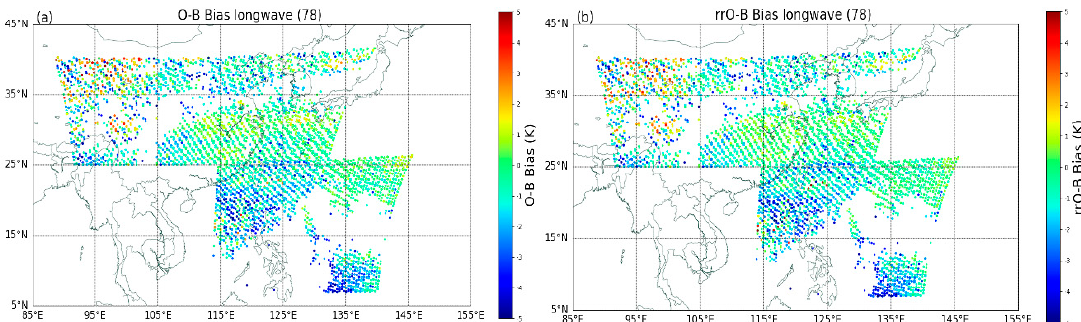
Remote Sens. 2019 , 11 , x FOR PEER REVIEW Figure 12. Spatial distribution characteristics of the ( a ) background departures (O-B) and ( b ) reconstructed background departures (rrO-B) of channel 78 during typhoon Mangkhut.